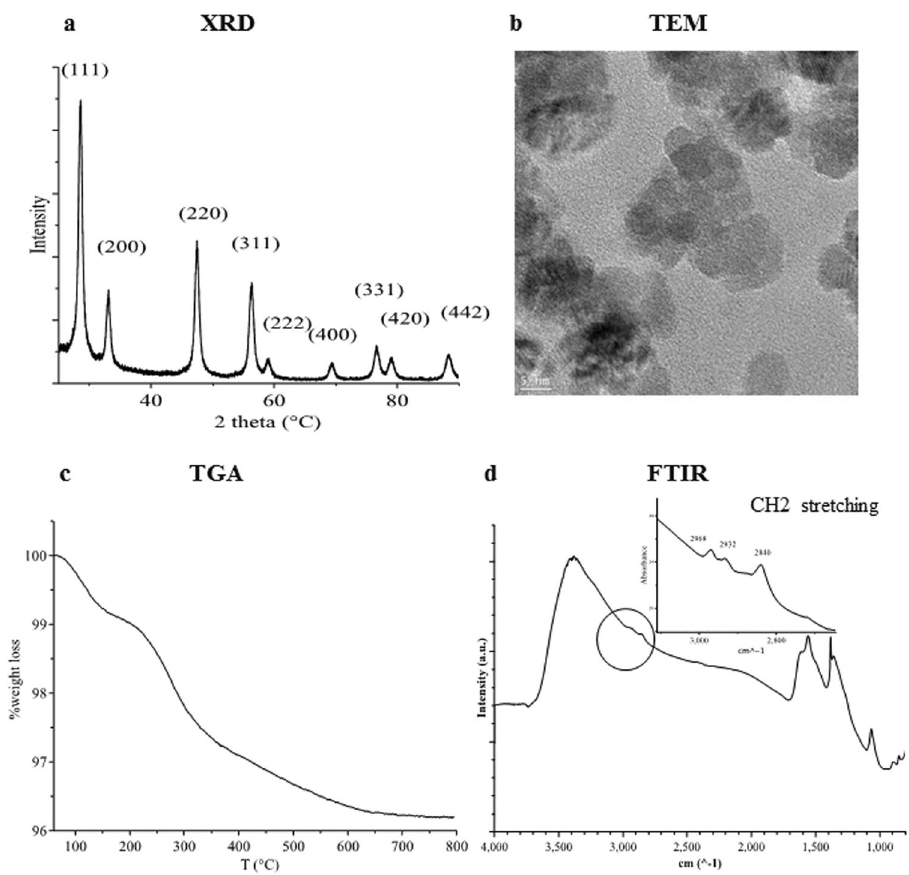
Figure 2. Physico-chemical characterization of C2 nanoparticles. ( a ) XRD diffraction patterns and Miller indexes. ( b ) TEM image. ( c ) TGA curve. ( d ) FTIR absorbance spectra; the inset shows the CH 2 stretching